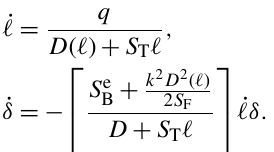
Figure 2. Schematic diagram of a perturbed